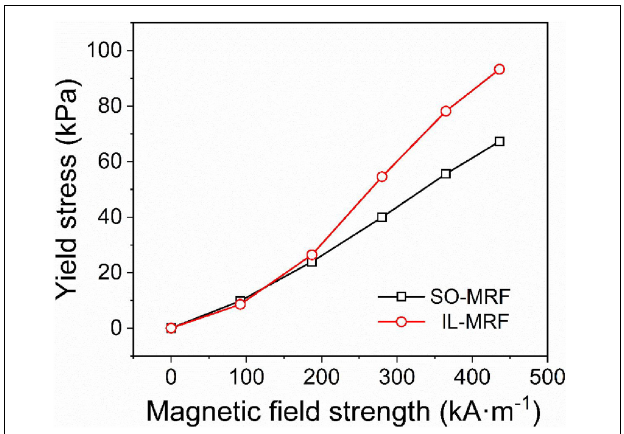
FIGURE 1 | Dependence of yield stress of SO-MRF and IL-MRF on magnetic field.